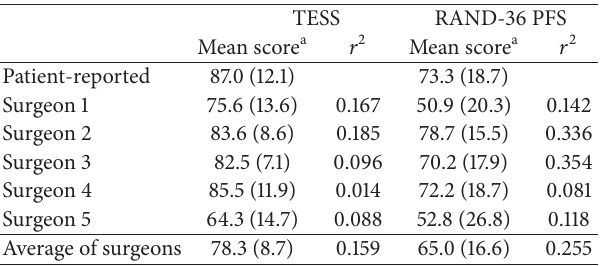
Table 2: Patient-reported and surgeon-predicted mean TESS and RAND-36 PFS scores and coefficients of determination for TESS and RAND-36 PFS